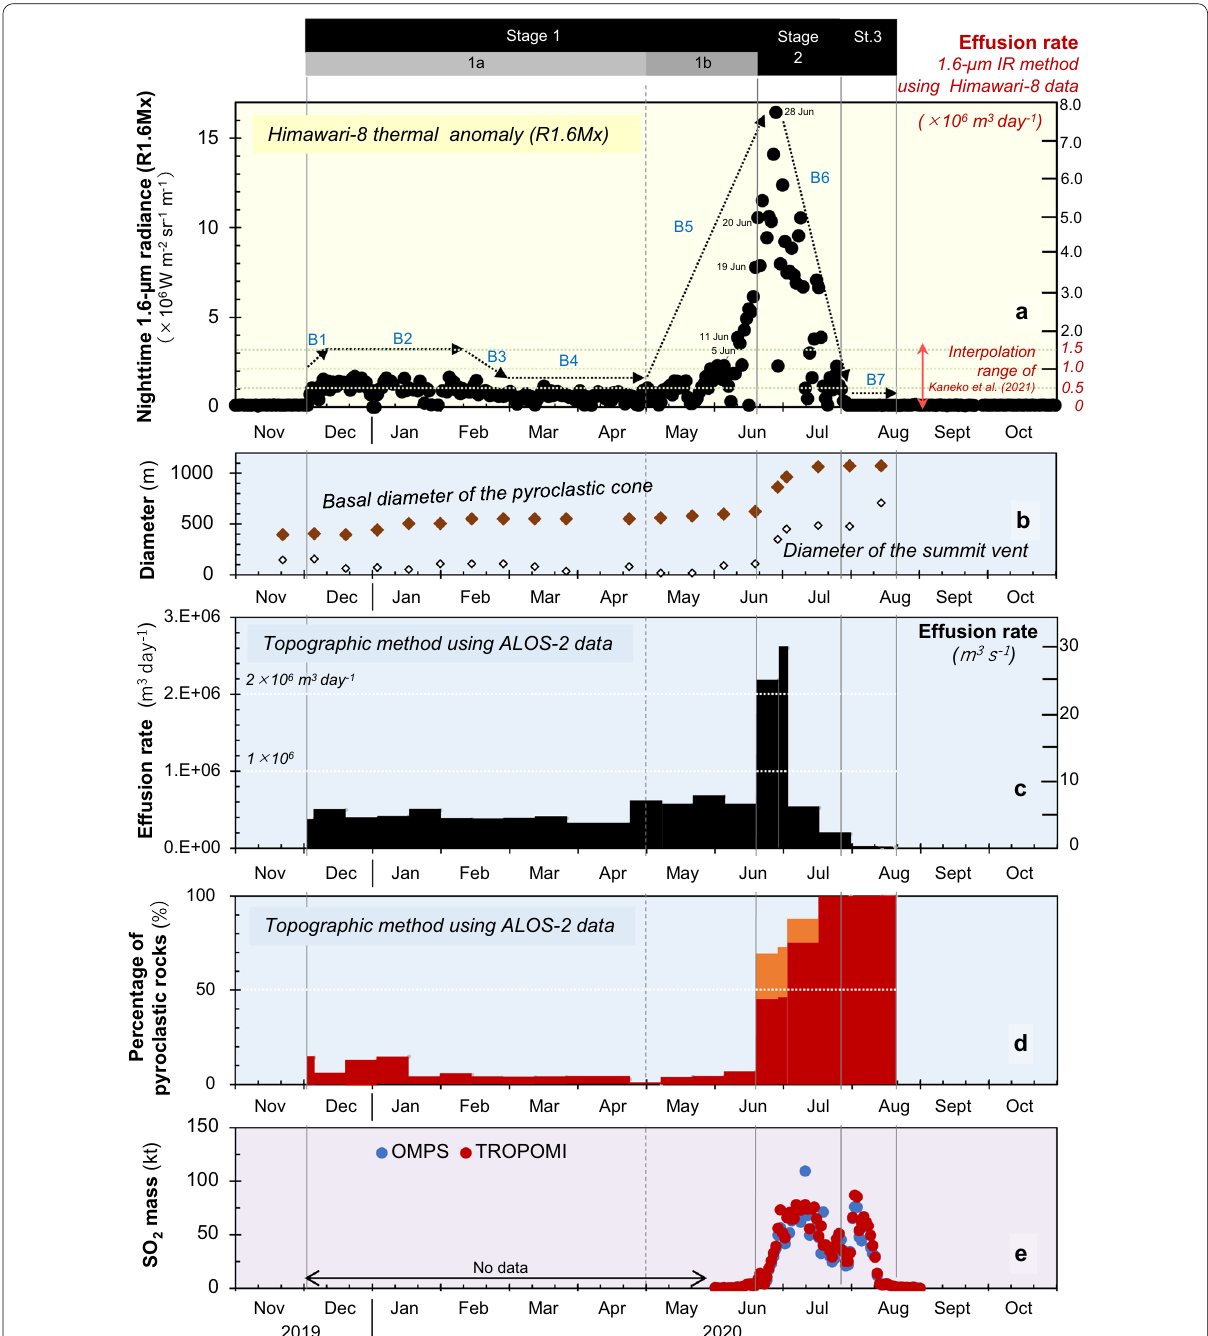
Fig. 3 Time-series vitiations of the parameters relating to the eruptive situation during the Episode 4 activity of Nishinoshima. a Time-series variation of the nighttime 1.6-µm radiance observed by Himawari-8 (R1.6Mx). The estimated effusion rate based on the 1.6-µm IR method (Kaneko et al. 2021) is shown on the right side. b Time-series variation of the basal diameter of the pyroclastic cone and diameter of the summit vent based on the ALOS-2 images. c Time-series variation of the effusion rate estimated by the topographic method using the ALOS-2 images. d Time-series variation of the content percentage of pyroclastic rocks in the erupted volume. The upper ends of the orange columns show estimations that assume 50% of the volume of the Stage 2 lava flows to have a pyroclastic origin. e Time-series variation of SO 2 mass in the Western Pacific area based on the ultraviolet–visible satellite observation (OMPS and TROPOMI) by the NASA Goddard Space Flight Center (NASA Goddard Space Flight Center